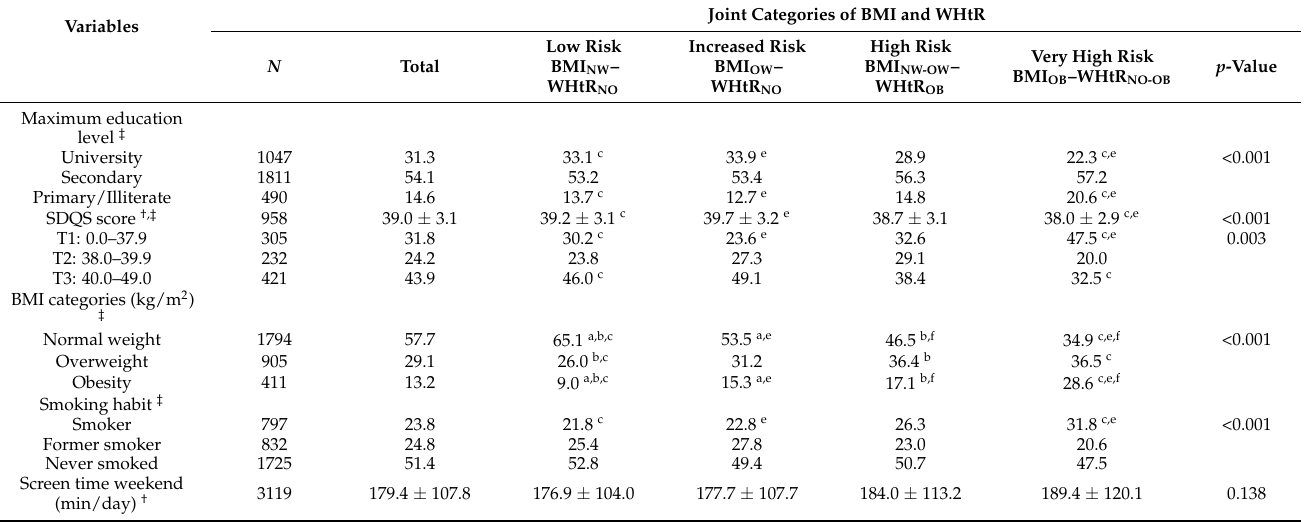
Table 2. Descriptive maternal characteristics of the study population relative to joint categories of body mass index (BMI) and waist-to-height ratio